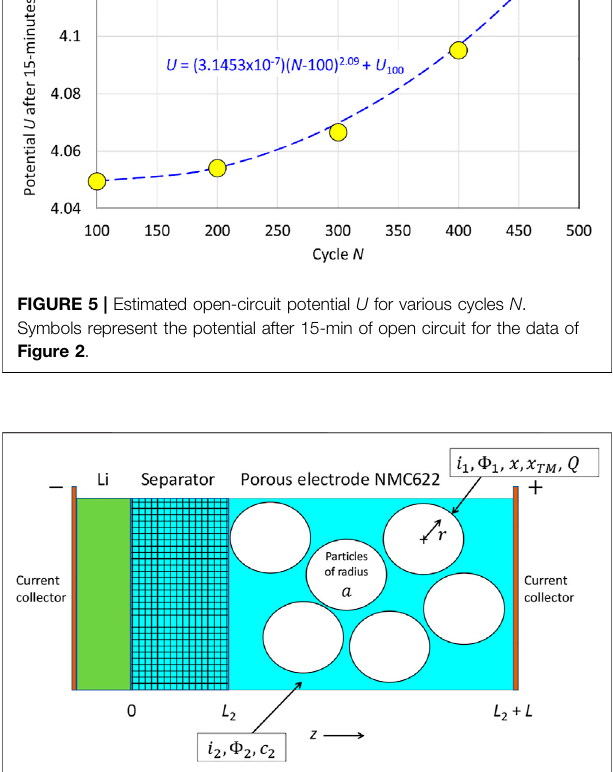
FIGURE6| Cellschematic.SeetheNomenclatureIndexforthemeaning of the variables